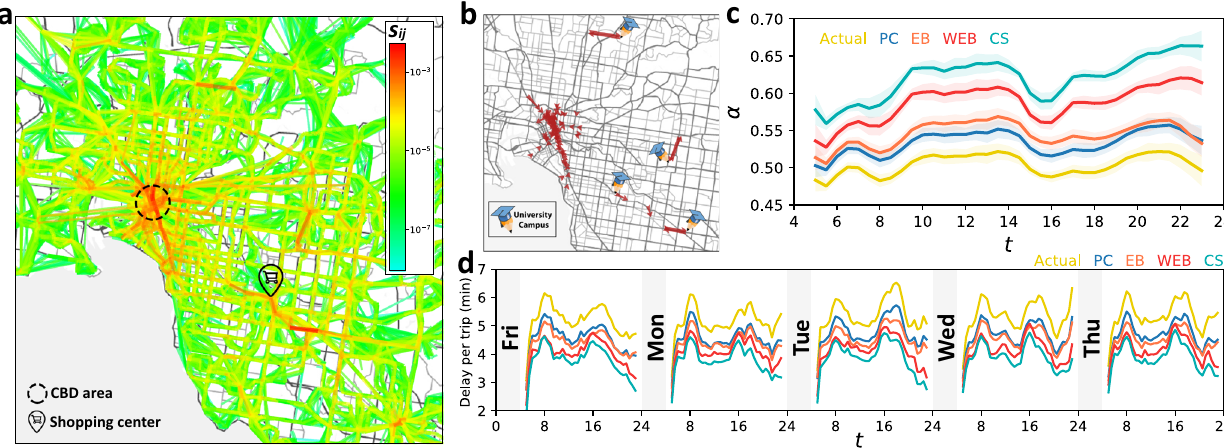
Fig. 6 Bottleneck identi fi cation and amelioration on a real-world network. a Spatial distribution of the link criticality scores s ij over Melbourne ’ s public transportation (PT) network during weekdays. The central business district (CBD) and the biggest shopping center in Melbourne are pinned on the map. b Top 100 weekday bottlenecks of Melbourne ’ s PT network, identi fi ed based on link criticality scores. Major university campuses outside Melbourne ’ s CBD area are pinned on the map. c , d The impact of ameliorating perturbations on bottlenecks identi fi ed by different approaches, i.e., criticality score (CS), edge betweenness centrality (EB), demand-weighted edge betweenness centrality (WEB), and percolation criticality (PC). The number of identi fi ed bottlenecks by each approach is equal to 2% of the average number of links that appear on the network. c Daily evolution of α calculated for the actual (yellow) and ameliorated networks associated with different bottleneck identi fi cation approaches. Results show the average (solid line) and standard deviation (shaded area) over the weekdays of September and October 2017. d Delay per trip (in minutes) caused by road congestions, on the actual and improved networks. Streetmap layers in a and b ©OpenStreetMap contributors 44